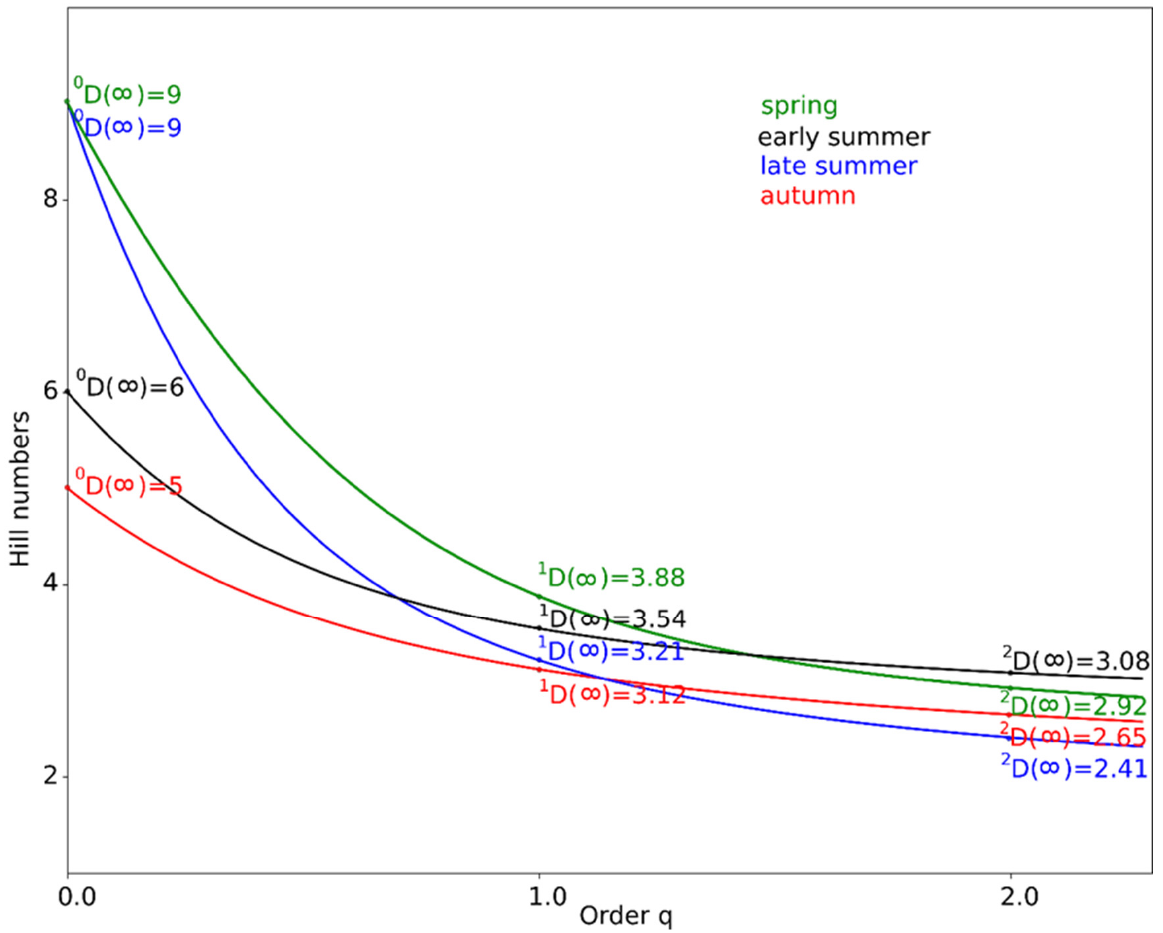
Figure 2. Diversity profile curve plotting Hill numbers for spring, early summer, late summer and autumn for bats (details in text).